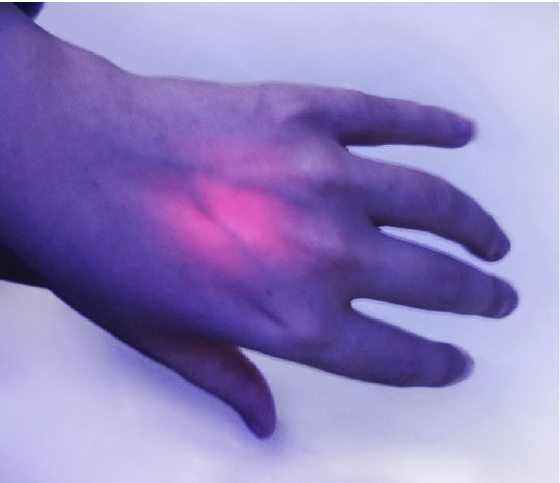
Figure 3. Penetration of near-IR light through tissues; illumination with a 650 nm LED light source.